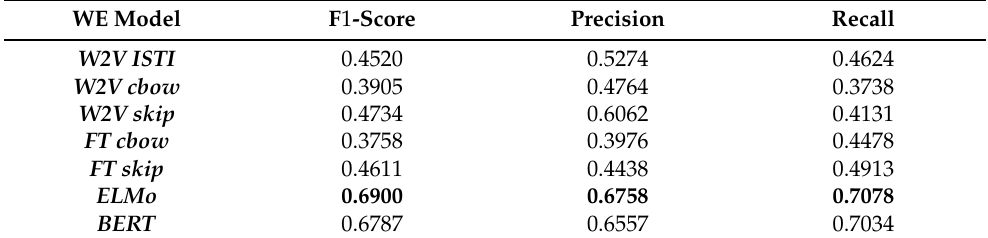
Table 5. Results in terms of F1-Score, precision and recall averaged on all classes obtained during the first training of the DNN of the AL phase, using different pretrained embedding models.